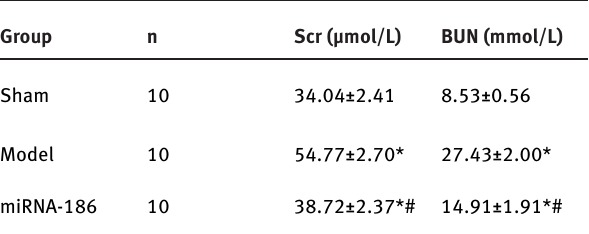
Table 1: Comparison of serum creatinine and urea nitrogen levels in each group (Mean±SD)